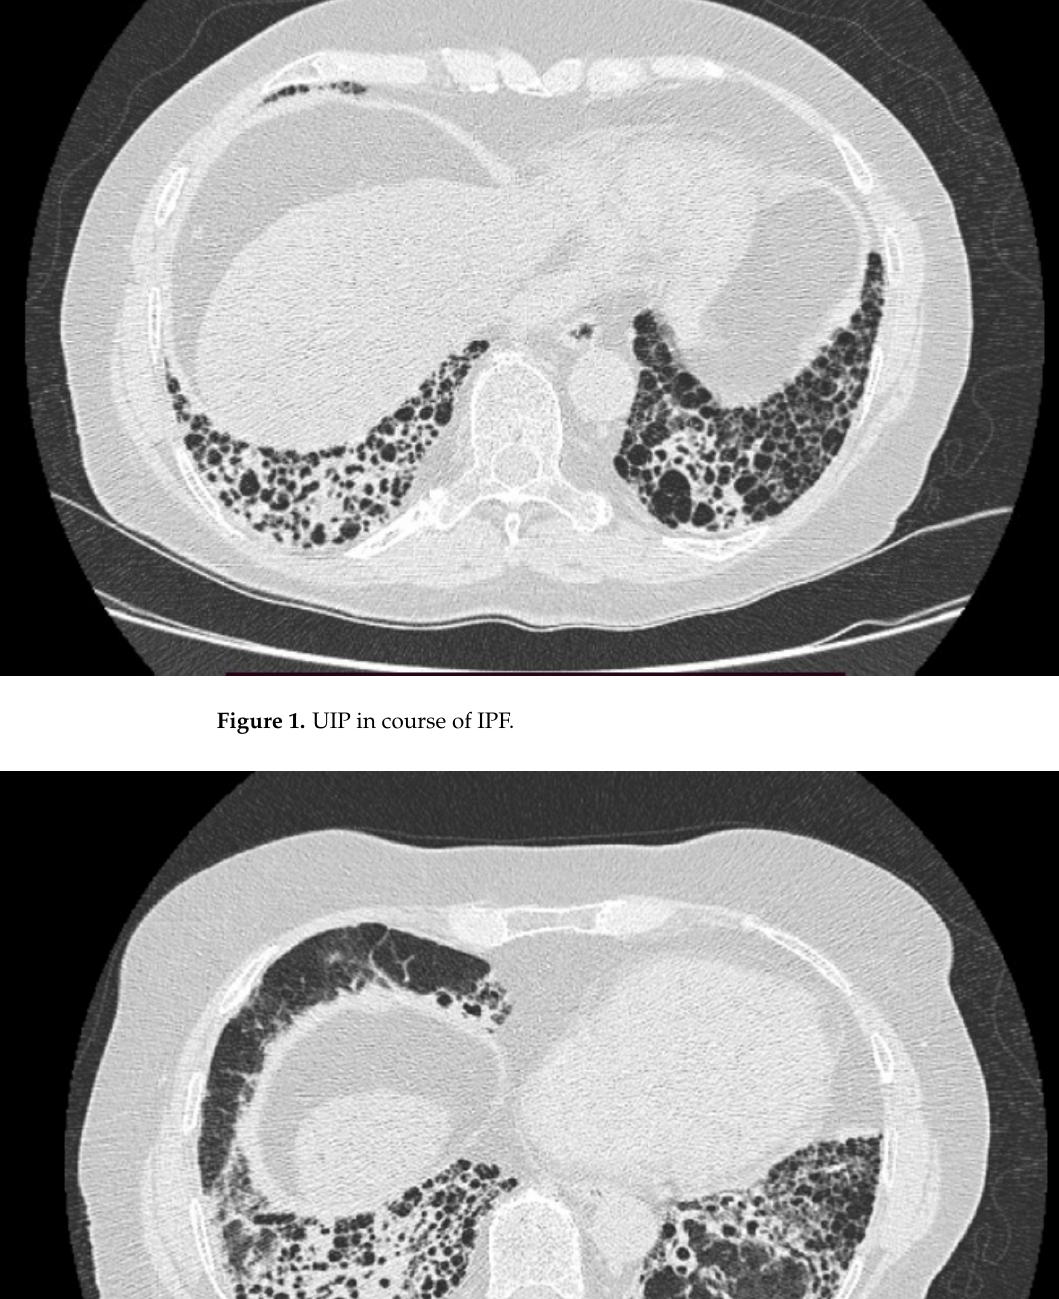
Figure 3. NSIP in course of IPAF.